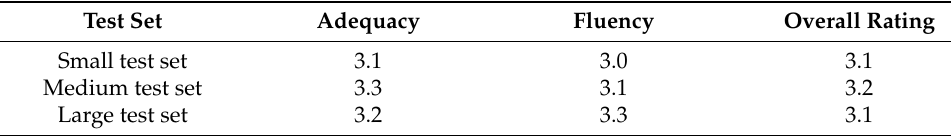
Table 11. Human assessment of NMT model 3.